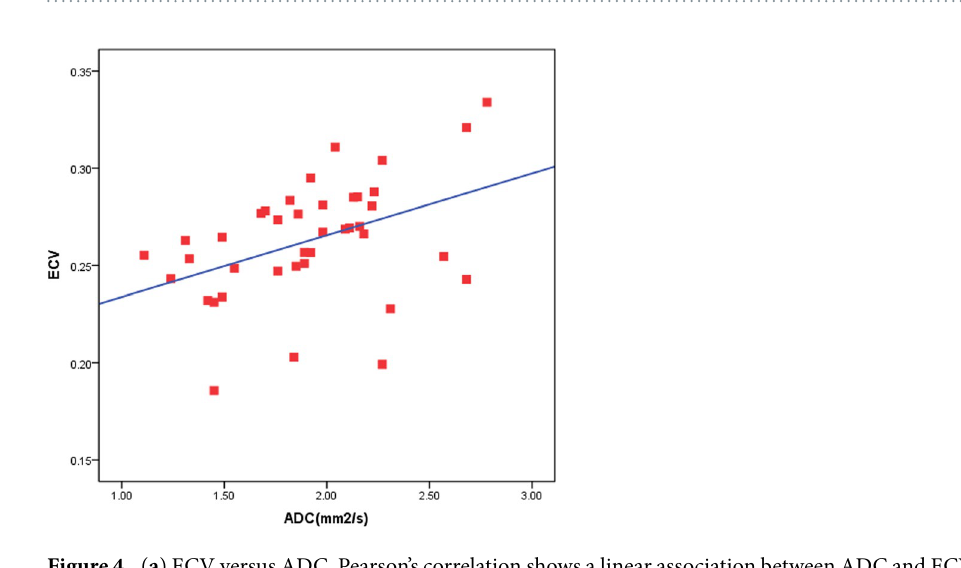
Figure 3. ( a ) Spearman correlation shows a positive association (Spearman rho = 0.26, p < 0.05) between ADC and LVMI. ( b ) Spearman correlation shows a positive association (Spearman rho = 0.18, p < 0.05) between ECV and LVMI.